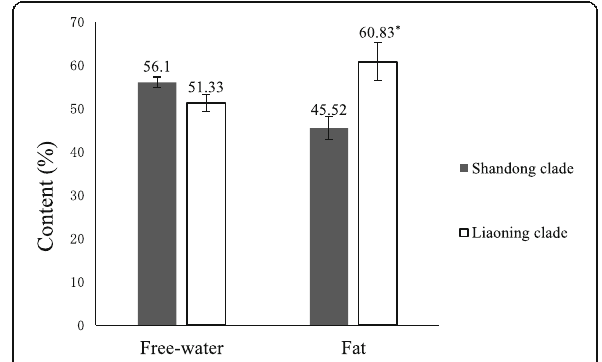
Fig. 2 Free-water and fat content of Aphelinus mali for two genetic clades found in China. Asterisk indicates a significant difference at the 0.05 level